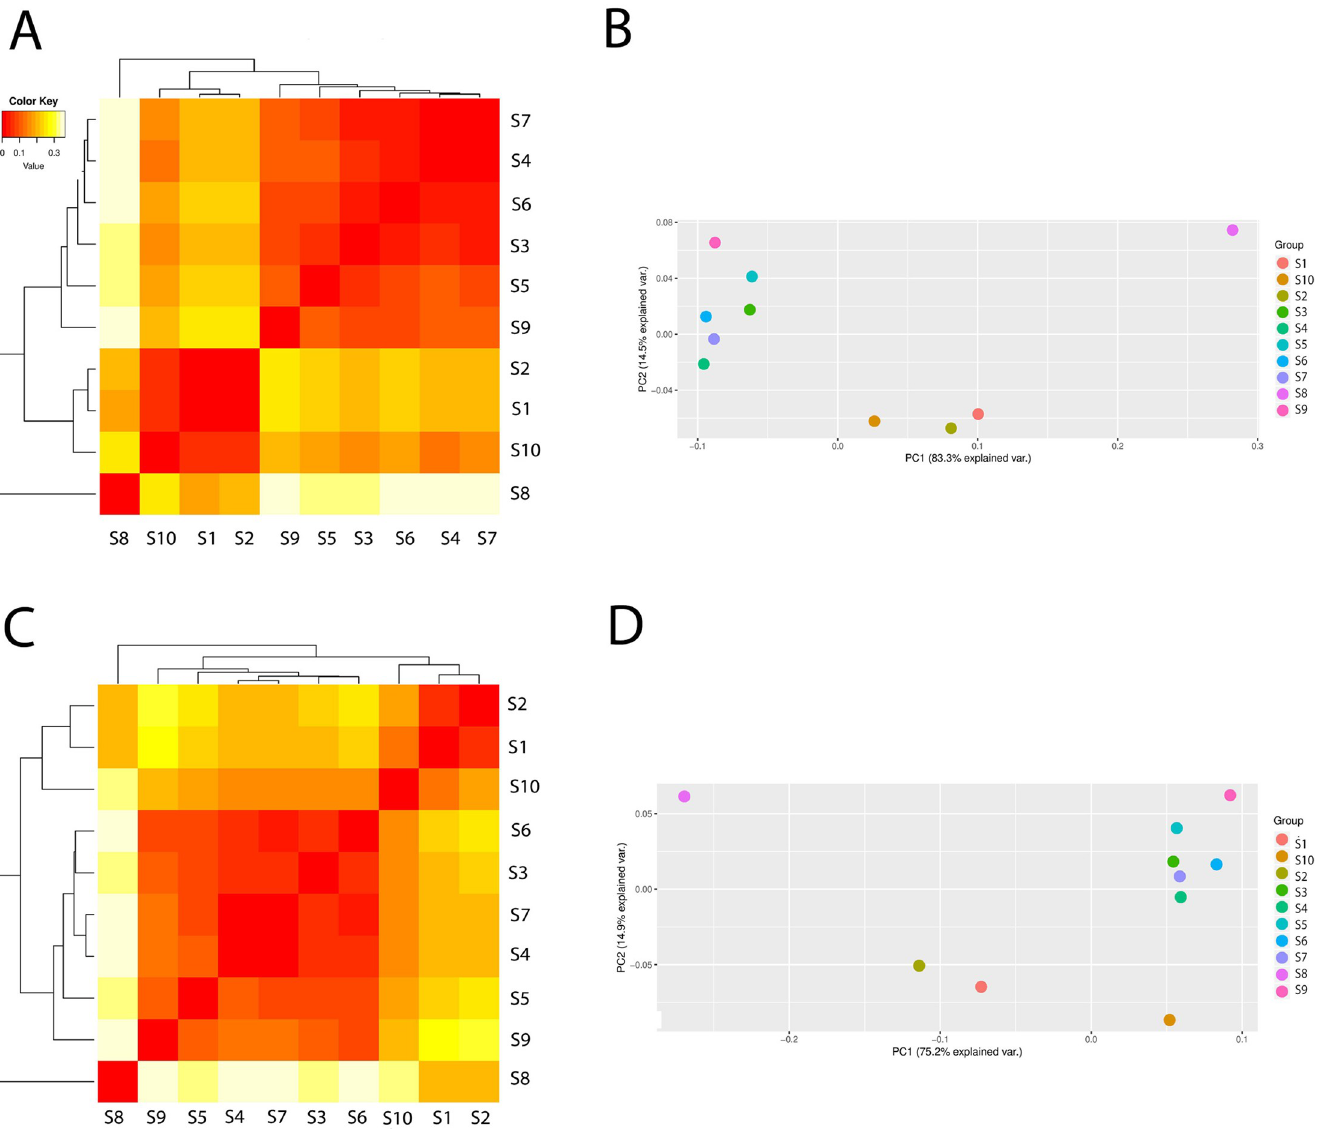
Fig 3. The differences in archaeal composition (beta diversity head map) and principal component analysis (PCA) based on the operational taxonomic unit abundance calculated by Bray-Curtis distance matrices, and presented at class level (A and B) and order level (C and D).